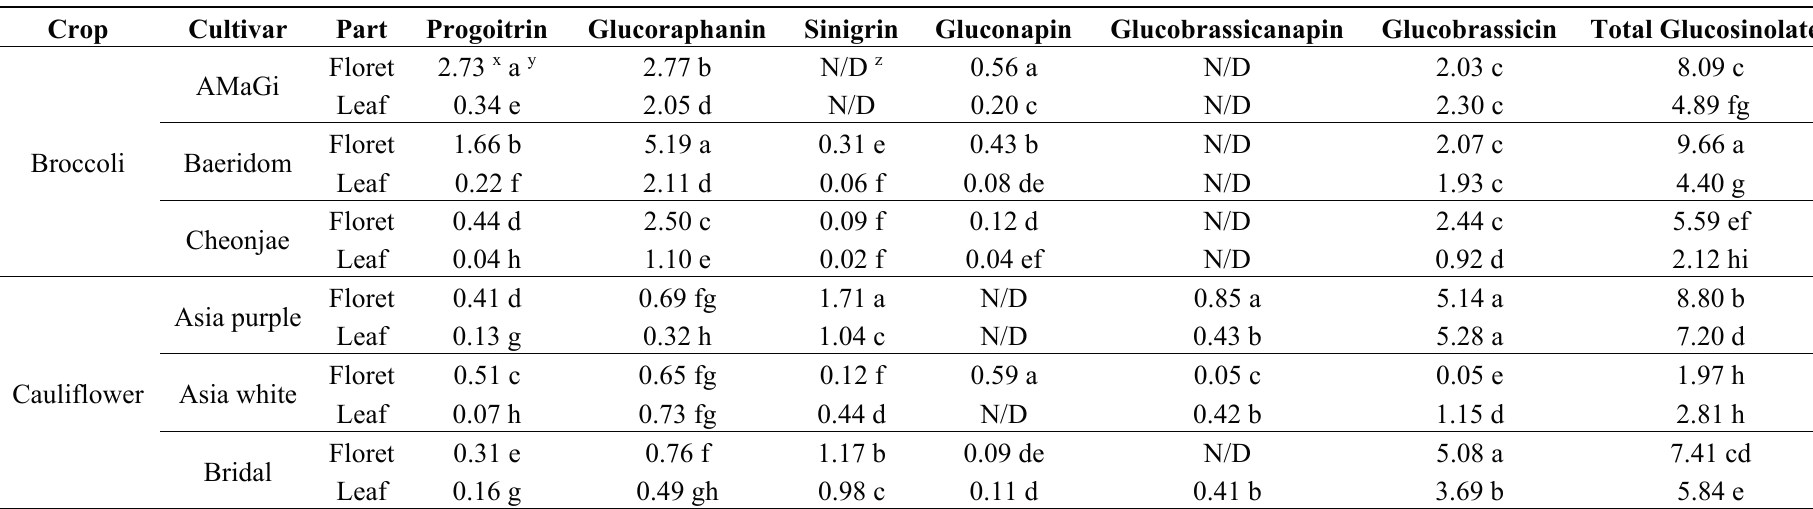
Table 1. Glucosinolate profile (µmol·g − 1 in dry weight) in various parts of broccoli and cauliflower